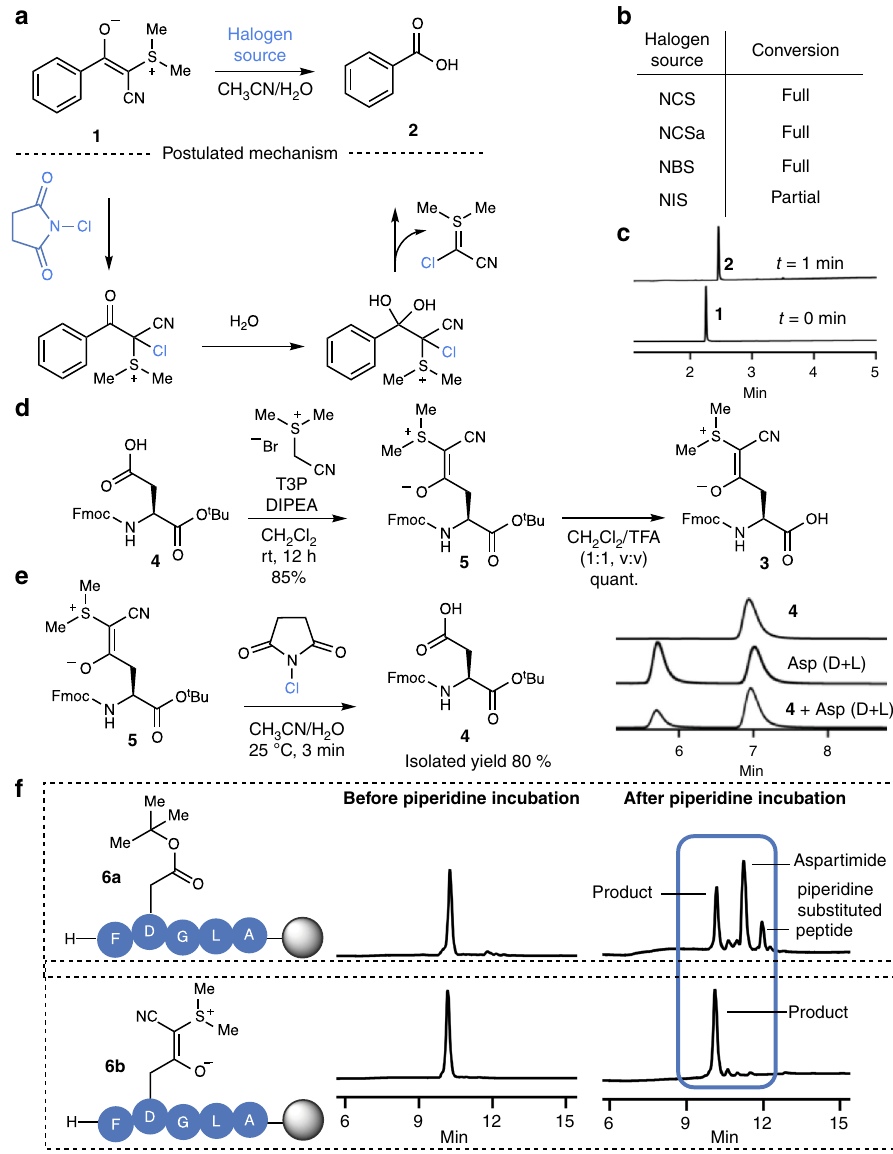
Fig. 2 Cyanosulfurylides as protecting groups for carboxylic acids. a Cyanosulfurylide 1 undergoes a rapid reaction with electrophilic halogen species, leading to the release of the unprotected carboxylic acid 2. A postulated mechanism proceeds via electrophilic halogenation followed by hydration and elimination of cyanohalogenylide. b Reaction screening was performed using cyanosulfurylide (5 mM) and electrophilic halogen species (10 mM) in aqueous solvent (CH 3 CN/H 2 O, 1:1); NCS = N-Chlorosuccinimide, NCSa = N-Chlorosaccharine, NBS = N-Bromosuccinimide, NIS = N-Iodosuccinimide. Reactions were analyzed by LC-MS after 1 min. c LC-MS traces of the reaction between sulfurylide 1 and NCS. d Fmoc-Asp(CSY)-OH 3 is readily synthesized from commercially available Fmoc-Asp(OH)-O t Bu 4 in two steps. e Reaction between aspartic acid monomer 5 and NCS was performed on a larger scale to determine the isolated yield (80%). Chiral HPLC traces showed that the stereoinformation is retained upon CSY removal. f Incorporation of cyanosulfurylide-protected aspartic acid into model peptide 6b and comparison with conventional O t Bu ester 6a upon incubation in 20% piperidine in DMF (12 h, room